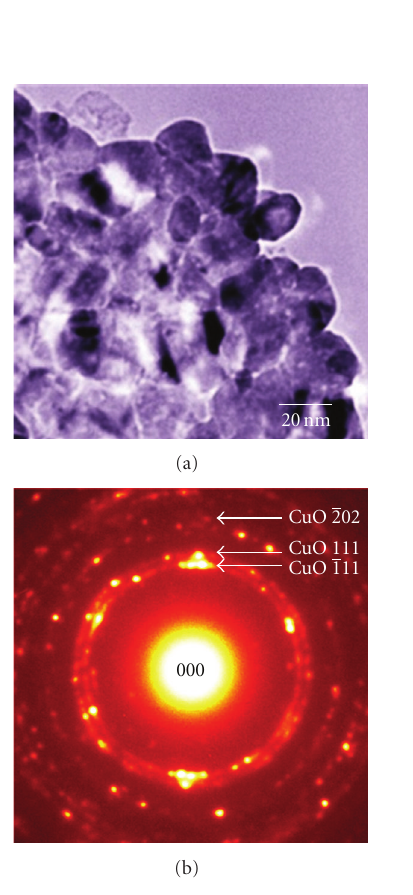
Figure 8: (a) TEM image and (b) electron di ff raction pattern of CuO structure.